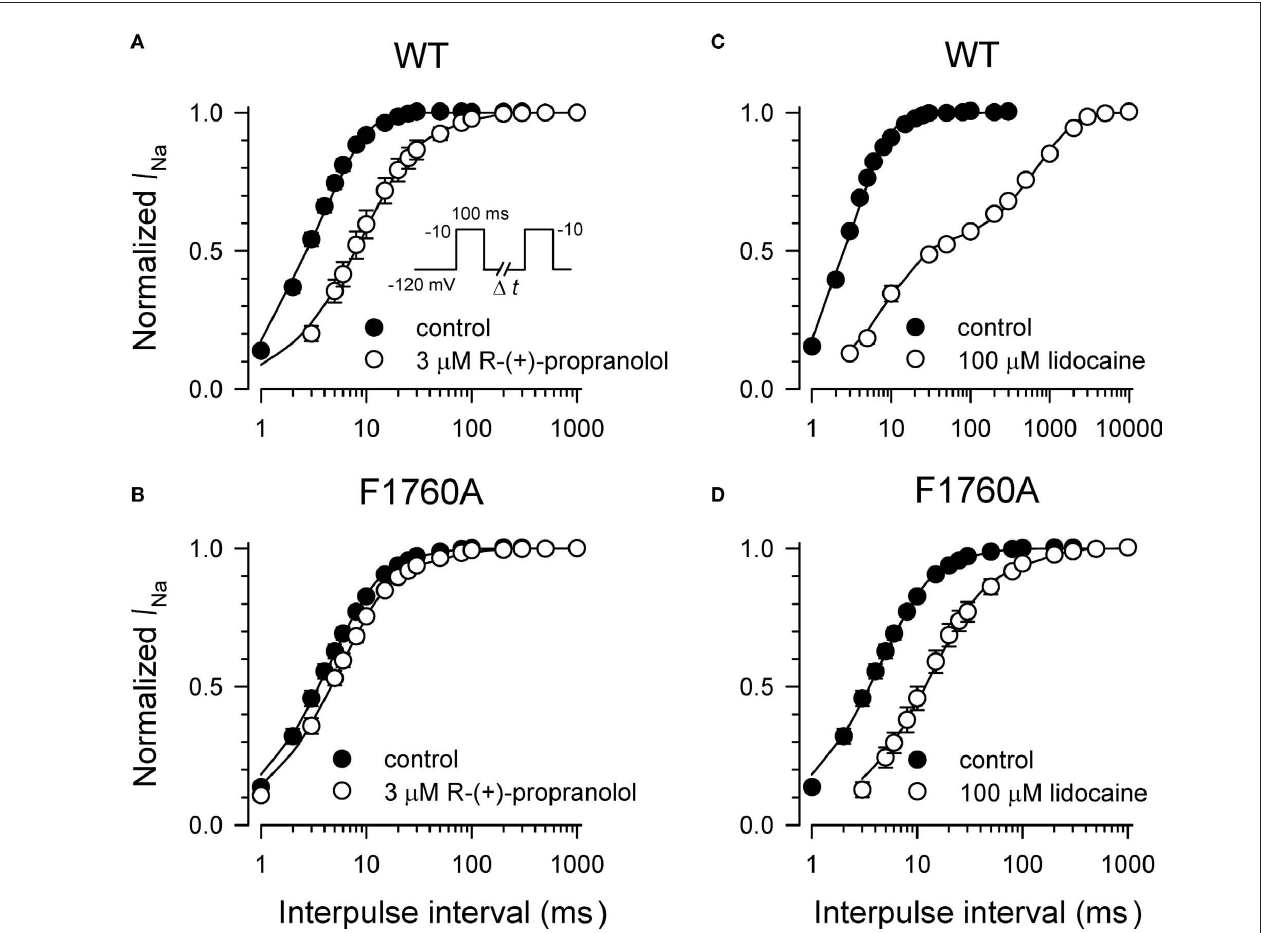
and 100 μM lidocaine on recovery from inactivation for WT-Na illustrated in (A,B) , respectively. The effects of 3 μM R-( + )-propranolol and 100 μM lidocaine on recovery from inactivation for F1760A channels are illustrated in (C,D) , respectively. Each point represents mean ± SEM from 7 to 14 cells.